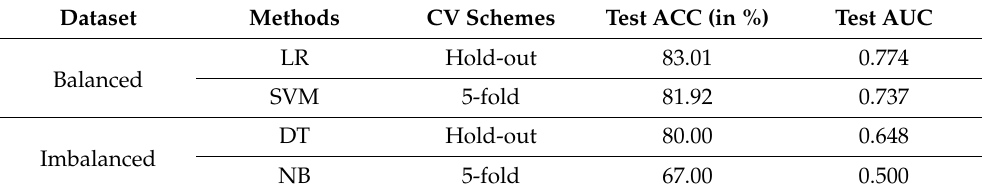
Table 10. Comparison: poor accuracy between balanced and imbalanced datasets with different CVs.